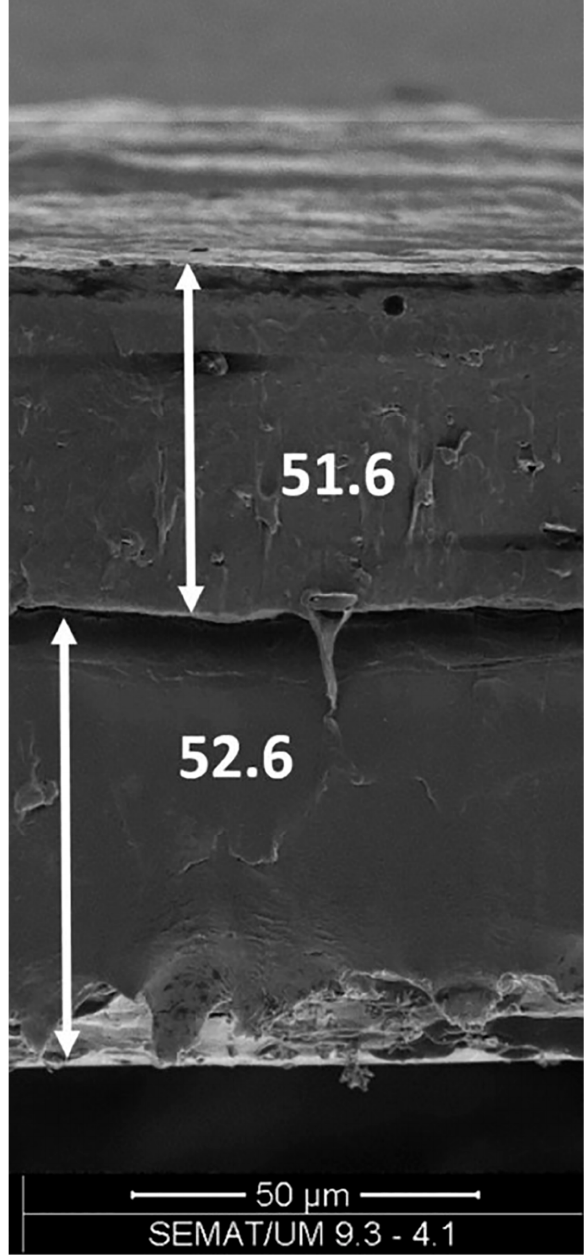
Figure 5. SEM image of bilayer PBAT/PHBV film (thicker layer is PHBV) prepared by Cunha et al.